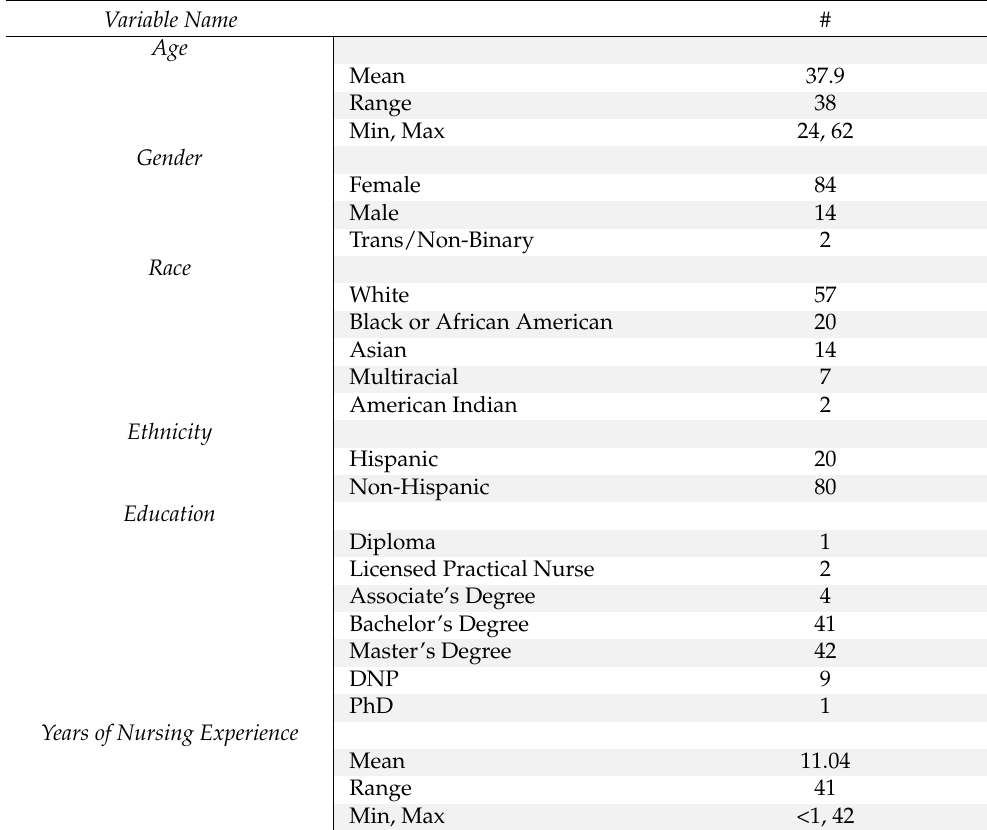
Table 1. Demographic Characteristics of Study